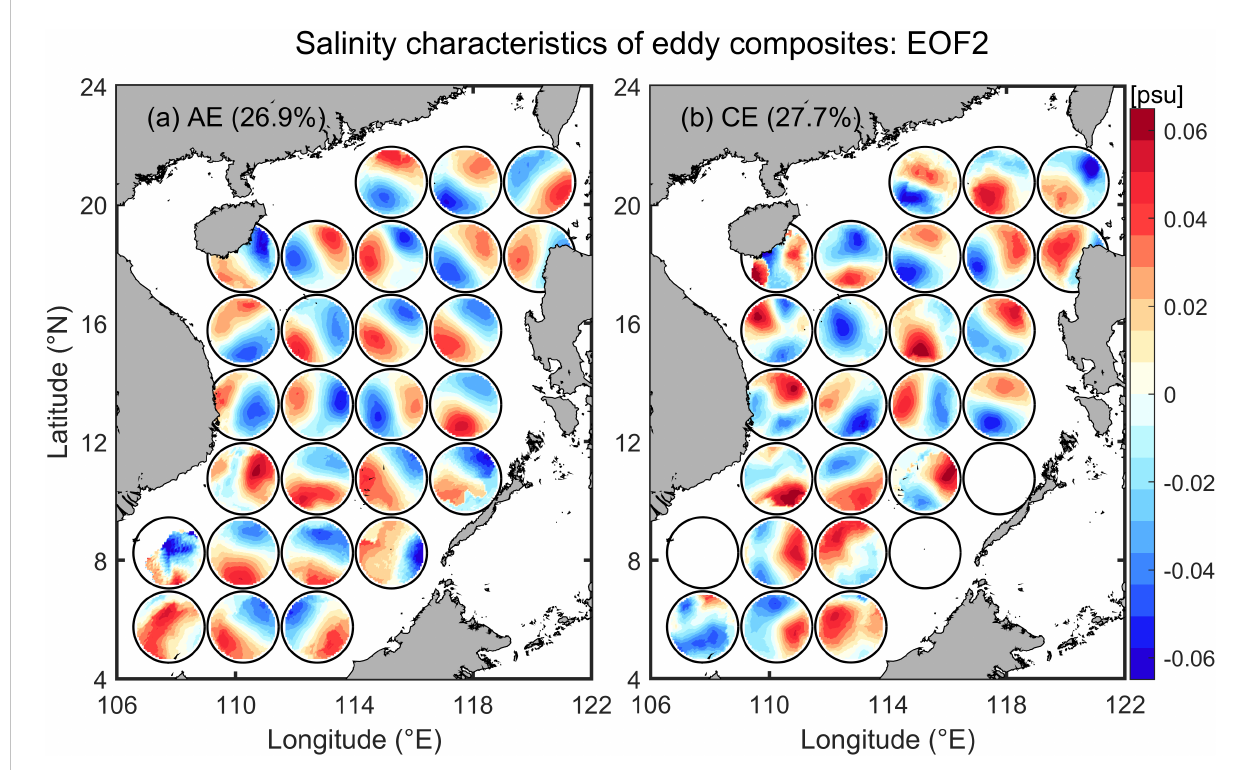
FIGURE 7 Similar to Figure 4 but for the second EOF mode of the (A) AE and (B) CE in the